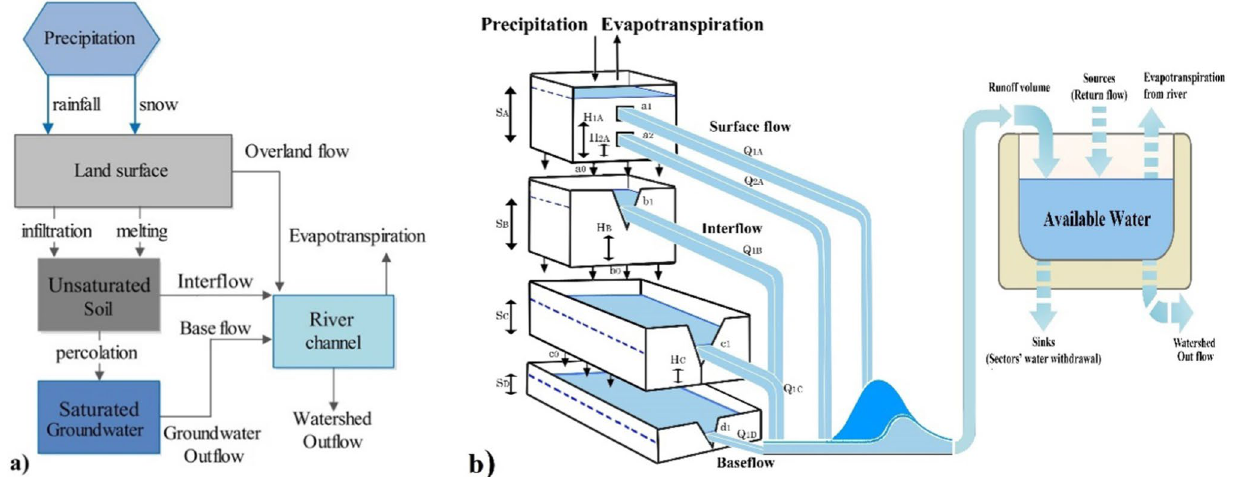
Fig. 2 Schematic representation of the hydrologic system dynamics model. a The conceptual hydrologic system dynamics model. b The Tank model and the Available Water stock. Available Water repre-